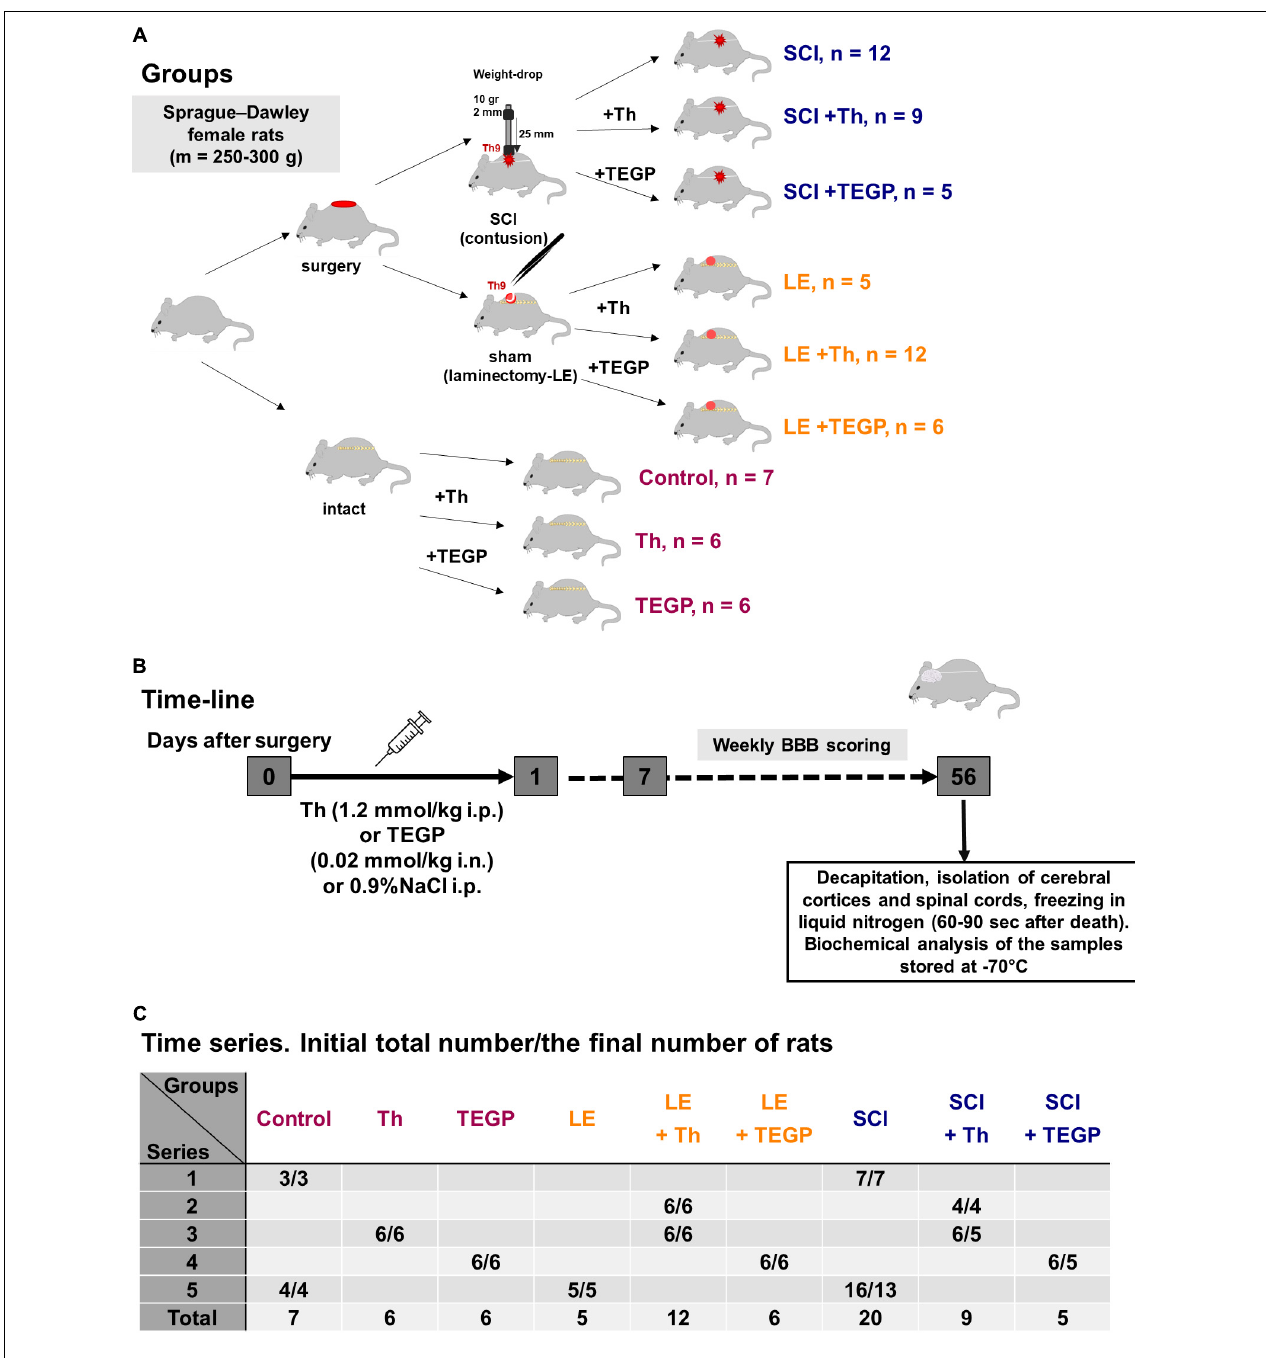
FIGURE 1 | Experimental flow-chart. (A) The overview of experimental procedures for each animal group. (B) The time-line of the procedures. (C) The serial distribution of rats across the groups.